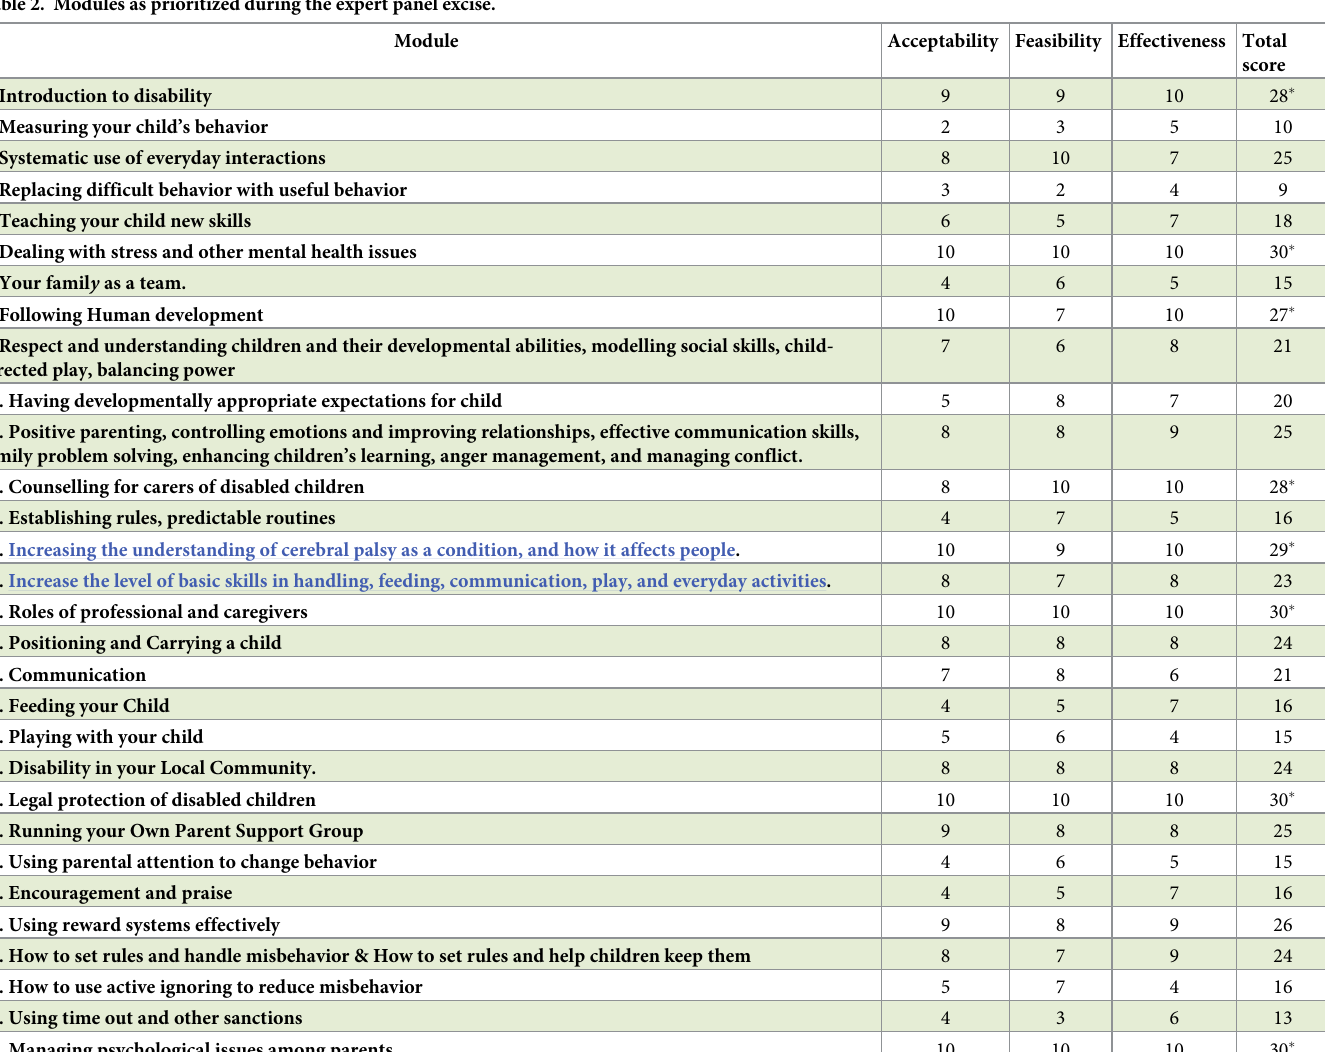
Table 2. Modules as prioritized during the expert panel